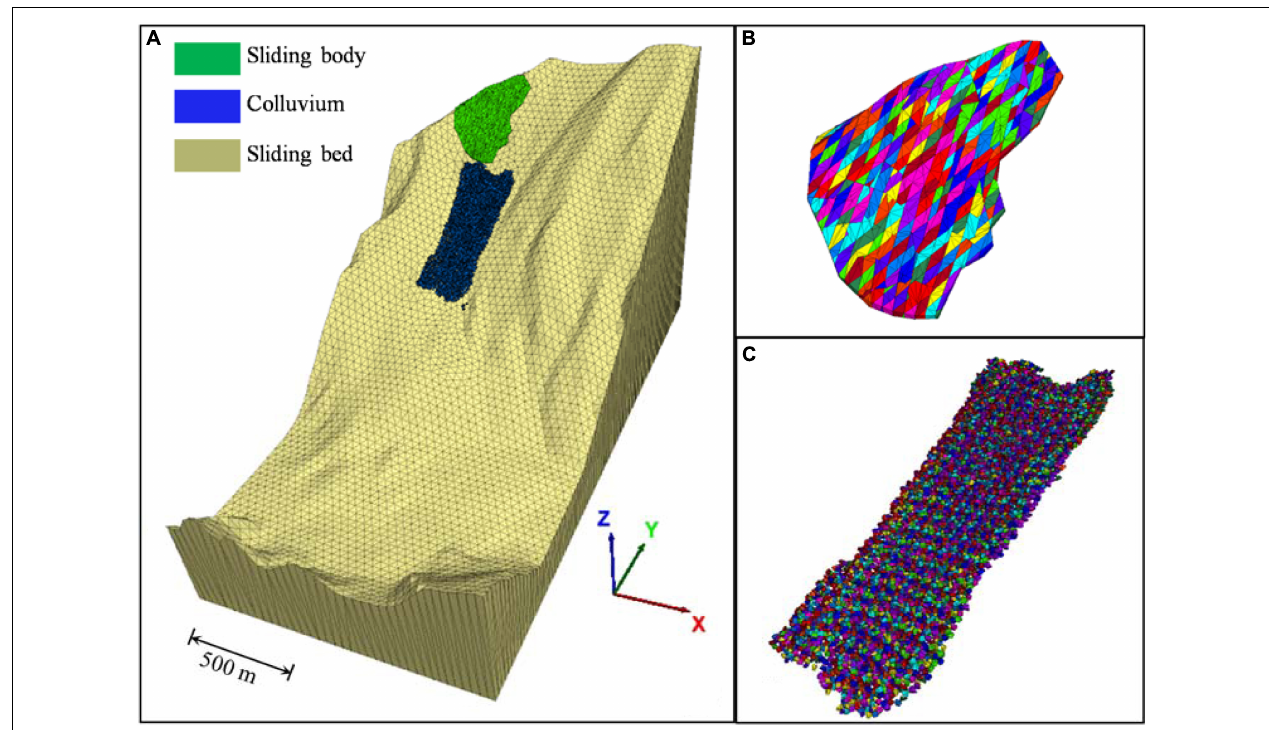
FIGURE 9 | Discrete element model of the Xinmo catastrophic landslide: (A) 3DEC model of the Xinmo Landslide; (B) simulated rock mass in the source area cut by three joint groups with an average space of 20 m and (C) simulated colluvium in entrained area as an assembly of Voronoi polyhedrons.